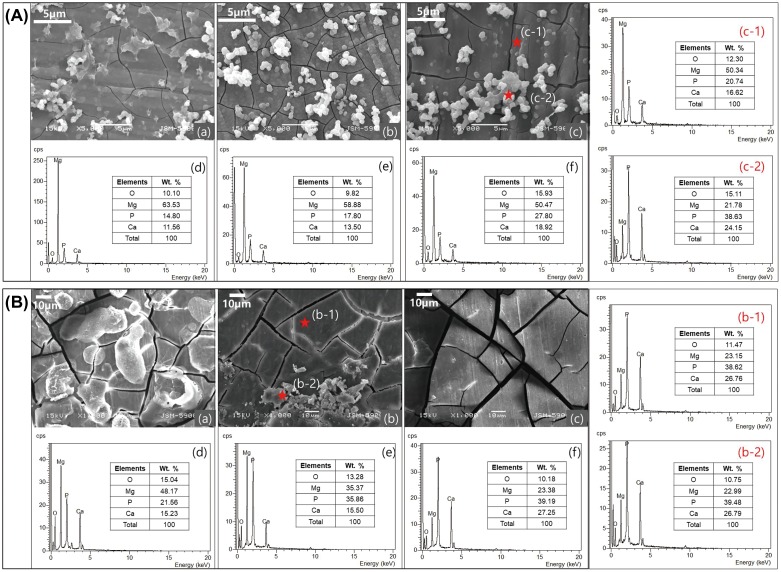
(A) SEM images of the Mg surface after immersion in EBSS for (a) 5, (b) 15, and (c) 30 days, EDX spectra after (d) 5, (e) 15, (f) 30 days, and EDX spectra of points (c-1) and (c-2) from image (c); (B) SEM images of the Mg surface after implantation to rat for (a) 5, (b) 15 and (c) 30 days, EDX spectra after (d) 5, (e) 15, (f) 30 days and EDX spectra of points (b-1) and (b-2) from image (b).